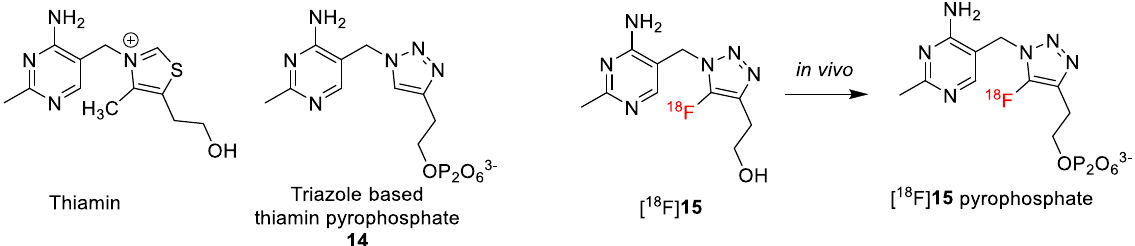
Figure 3. Structure of thiamin, triazole-based thiamin pyrophosphate, and the fluorine-18-labeled triazole based analogue of thiamin undergoing in vivo pyrophosphorylation.